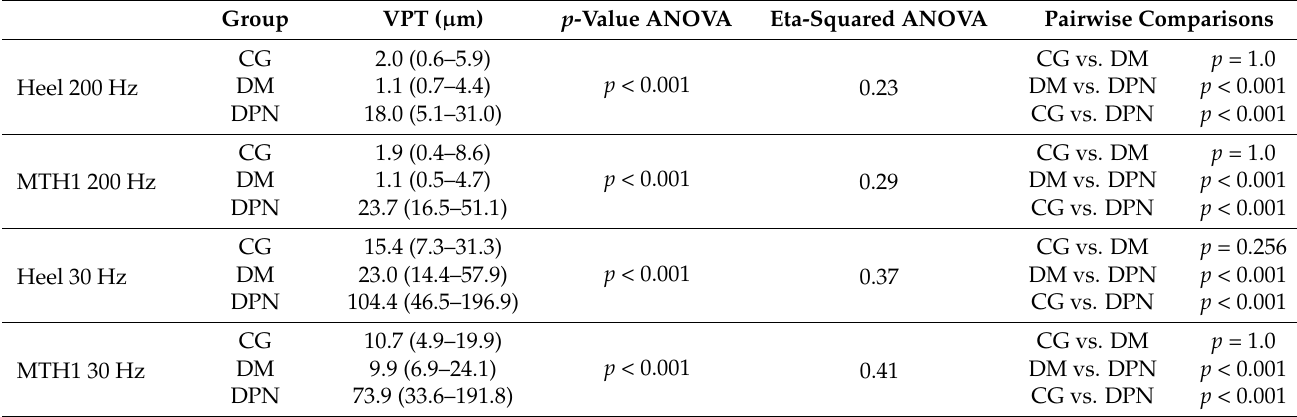
Table 2. Vibration perception thresholds for the control group (CG), diabetes group (DM), and DPN group (DPN) in µ m for both frequencies and locations.